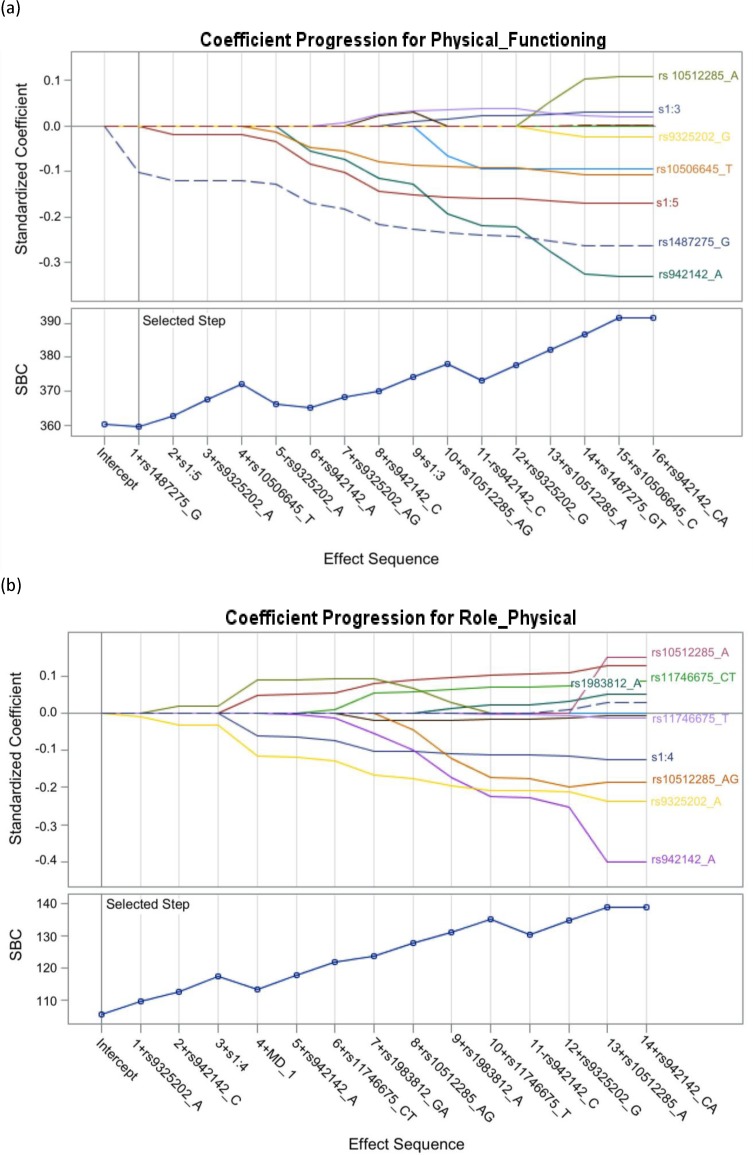
The LASSO regression model.(a) A risk factor rs1487275_G was selected in the LASSO regression model. (b) No risk factor was selected in the LASSO regression model to predict Role-Physical of QoL.